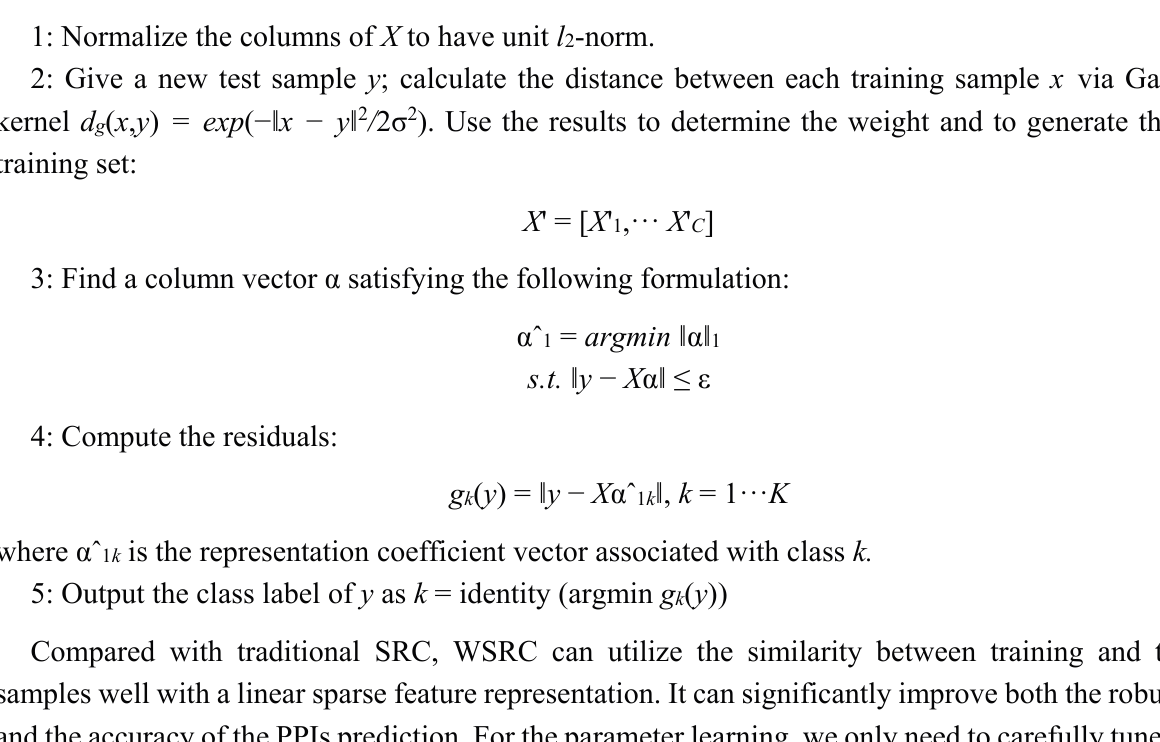
Algorithm 1: The WSRC